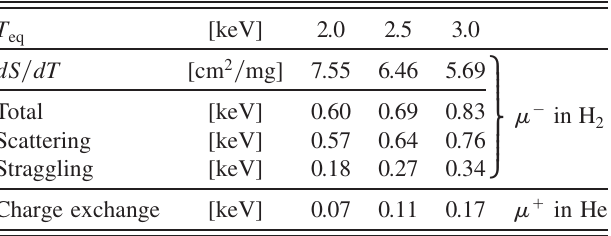
Charge exchange [keV]